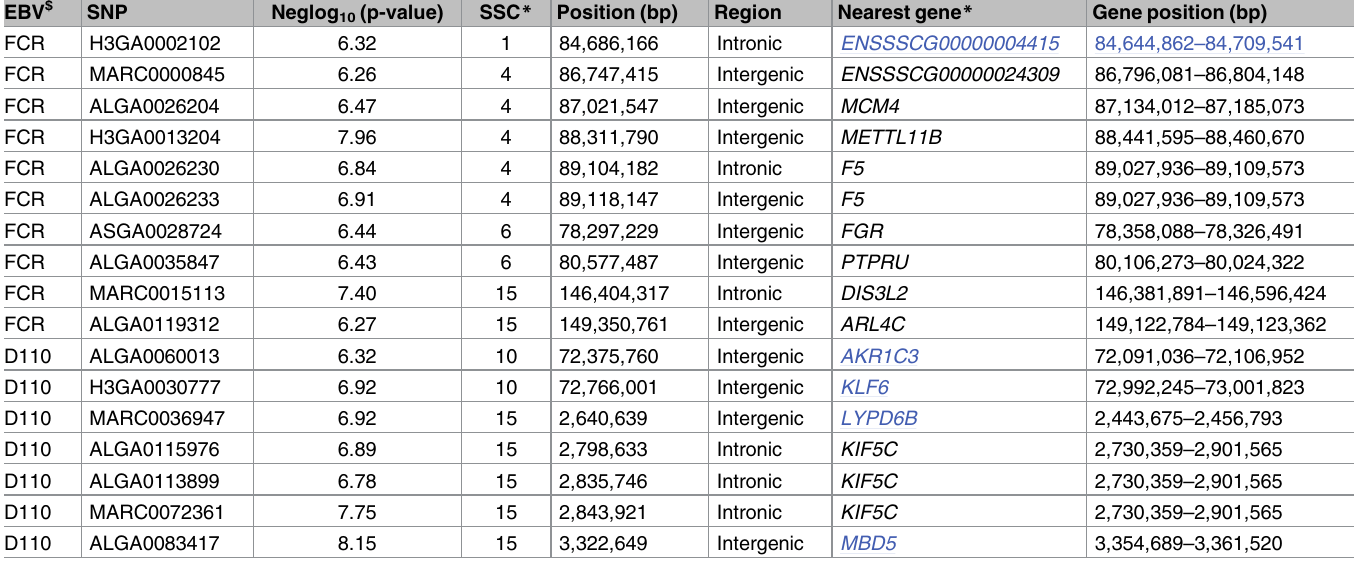
Table 2. Genes located closest to the genome-wide significant SNPs.